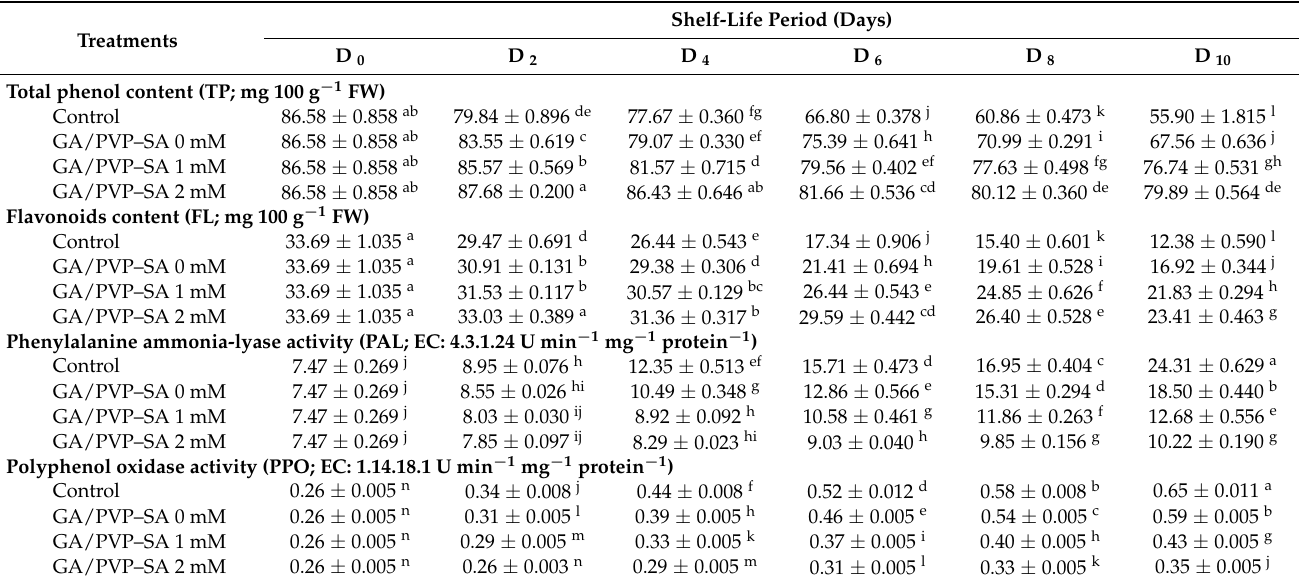
Table 2. Effect of different treatments of gum arabic (GA) and polyvinylpyrrolidone (PVP) blend- ing with salicylic acid (SA) at different concentrations as a mixture biopolymer coating treatment (GA/PVP–SA) on skin browning elements of peach fruit ‘Early Sweet’ during shelf life at ambient air (29 ± 1 ◦ C and air humidity 51%) during two seasons (2020 and